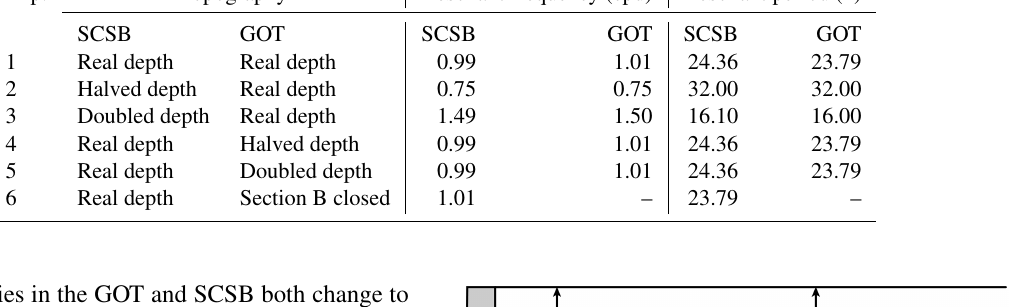
Table 2. Resonant frequencies and periods obtained from the six experiments. Exp.